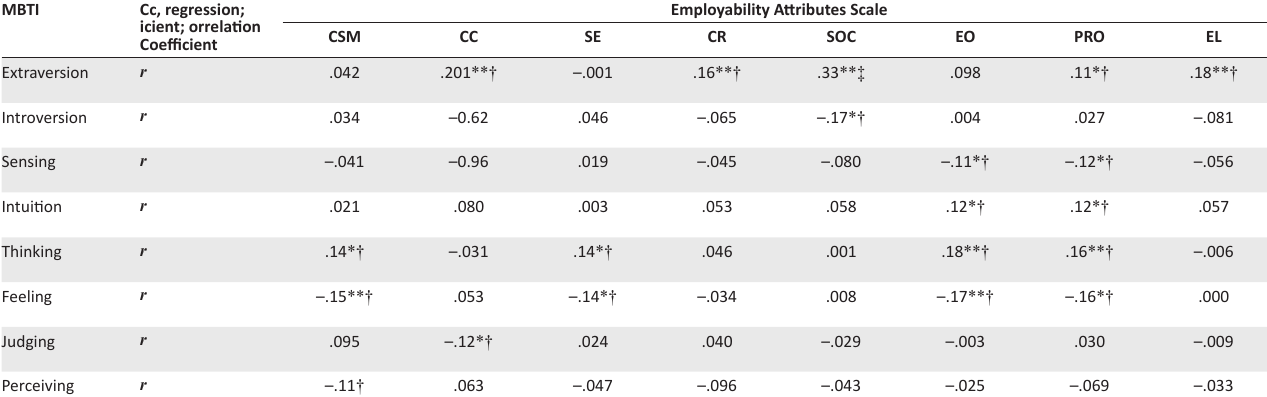
TABLE 4: Spearman correlations: Myers-Briggs Type Indicator ( MBTI) and Employability Attributes Scale ( N = 304). MBTI Cc, regression; icient;